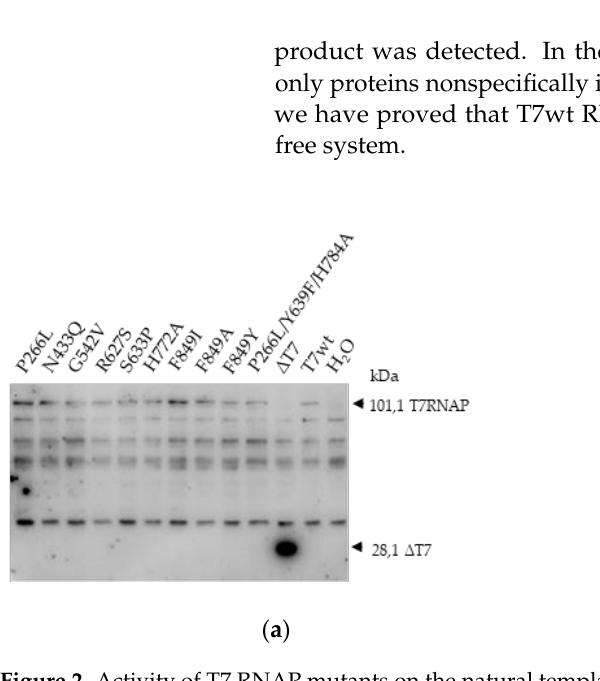
Figure 2. Activity of T7 RNAP mutants on the natural template. ( a ) Expression level of T7 RNAP mutants in the coupled 2 cell-free system. Western blot of the WGE lysate where T7 RNAP mutants were synthesized. ( b ) Activity of the mutants of T7 RNAP normalized on the amount of T7 RNAP synthesized in the coupled 2 cell-free system using natural template, n = 3, mean ± SD .